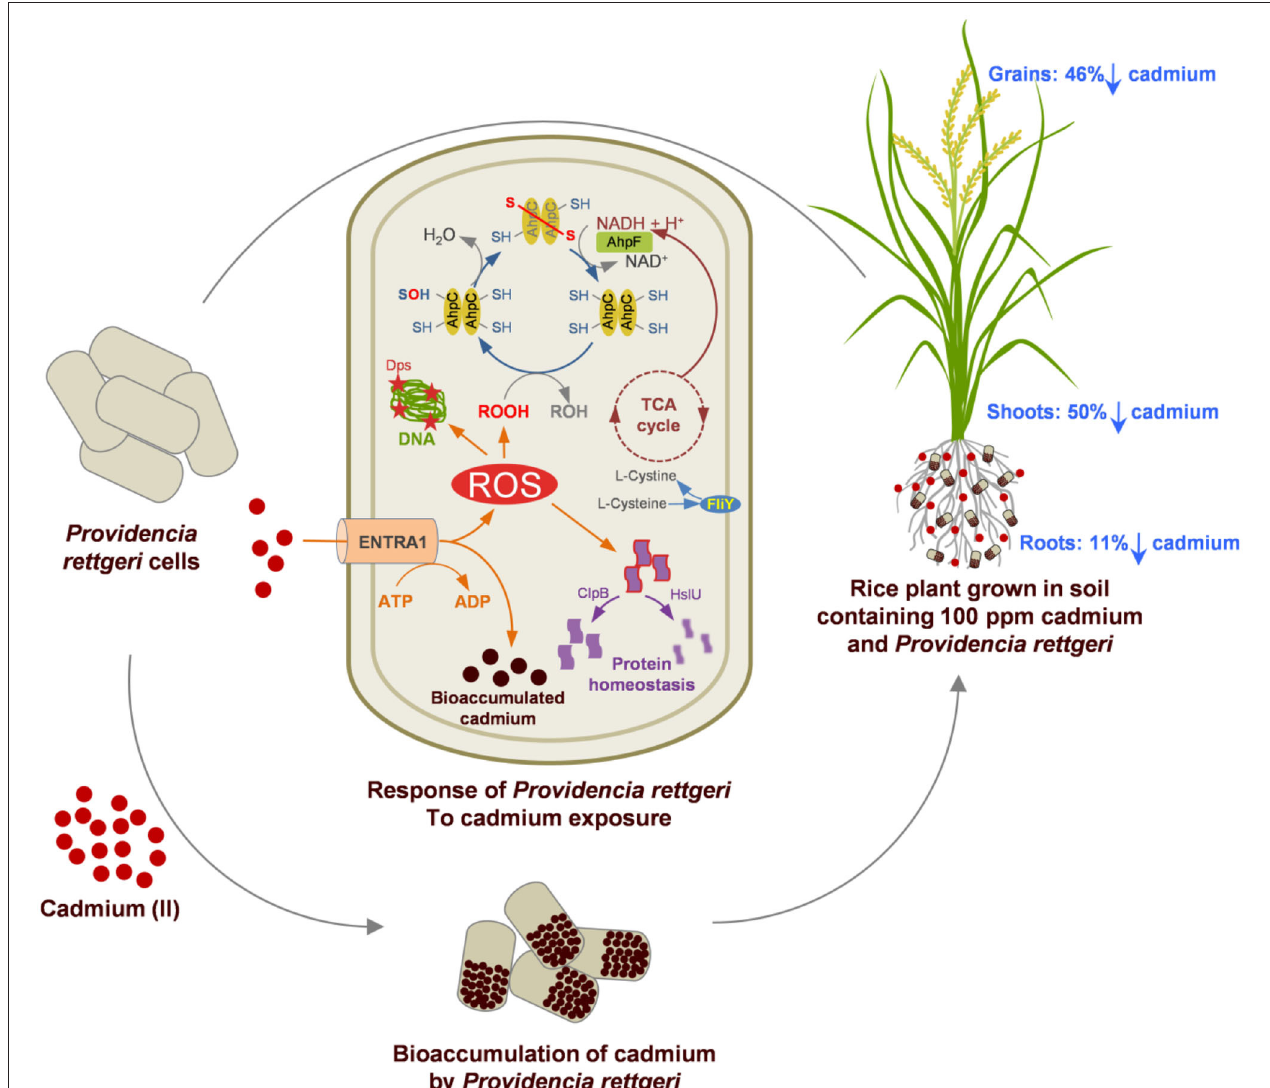
FIGURE 6 | A proteome and rice ecosystem-based model for the Cd tolerance and in-situ bioremediation potential of P. rettgeri KDM3 strain. Red dots represent Cd present in the soil, and brown dots indicate intracellularly accumulated Cd in the P. rettgeri cells. Percentage reduction in cadmium concentration in roots, shoots, and grains is shown by down arrows. The model at the center depicts the Cd responsive proteins involved in Cd tolerance and their possible role in Cd accumulation and cellular homeostasis. For details of Cd responsive proteins, refer to Supplementary Table S2